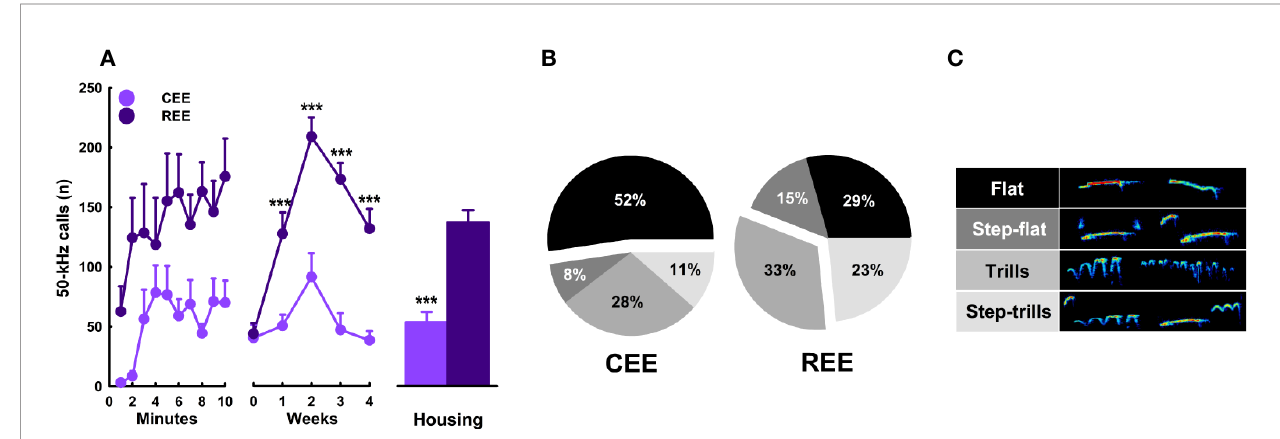
FIGURE 4 | Kinetics of ultrasonic vocalizations in the environmental enrichment cage. Total number of 50-kHz calls (A) over minutes (left panel), weeks (middle panel), and its cumulative average (right panel). Fifty-kHz calls' subtypes (B) and their respective exemplary sonograms. (C) Data correspond to frequencies (A) and percentages (B) expressed as mean ± SEM. CEE, continuous environmental enrichment; REE, restricted and unpredictable environmental enrichment. Single, pairwise-comparisons between groups: *** p <